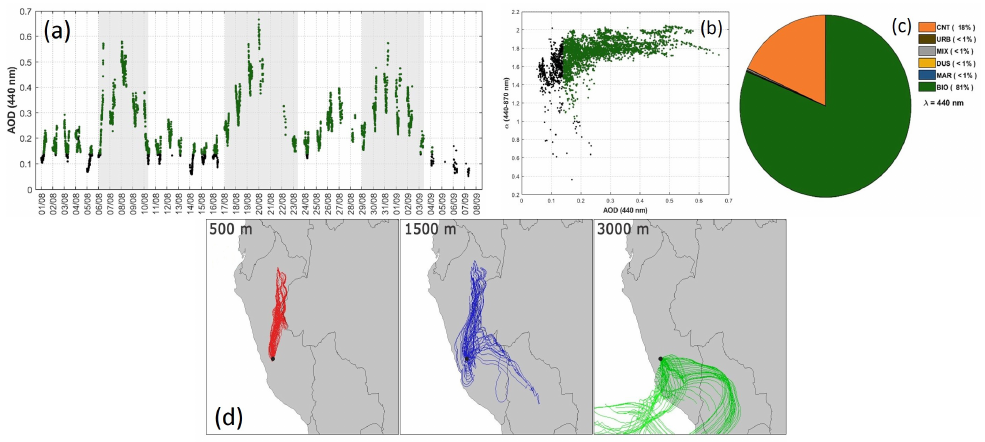
Figure 15. ( a ) AOD at 440 nm between 1 August and 8 September 2019. Green dots represent the AOD related to biomass aerosols, and black dots represent the other aerosols types. ( b ) Scatterplot of AOD (440 nm) vs Angstrom parameter (440–870 nm) for aerosol classification. The green dots represent the classification of biomass aerosols and black dots other aerosols types. ( c ) Percentage of presence of each type of aerosol according to the classification performed. ( d ) Backtrajectories calculated with HYSPLIT for every days between 17 August and 23 August 2019 for three levels: 500, 1500 and 3000 m. Trajectories were calculated every 3 h and for 120 h